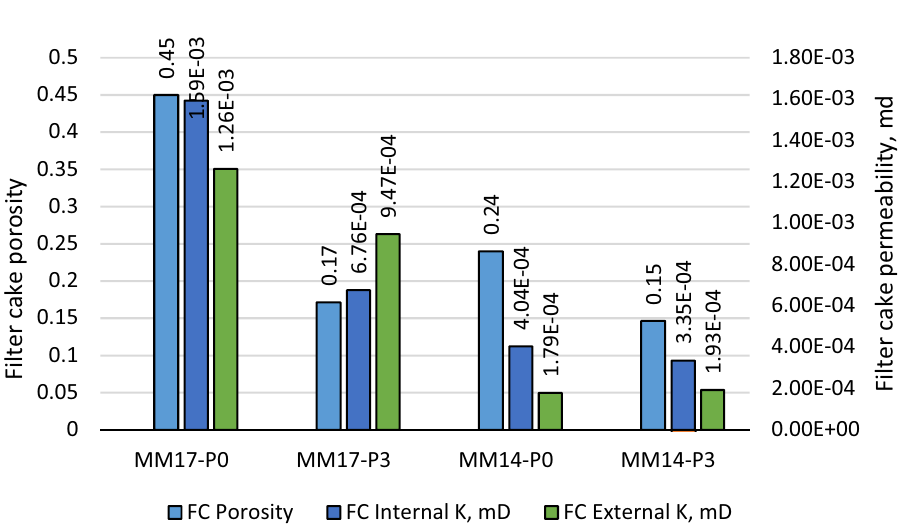
Figure 10. Porosity and the layer permeability of filter cake as function of perlite for mud samples with perlite concentrations equal to 0 and 3